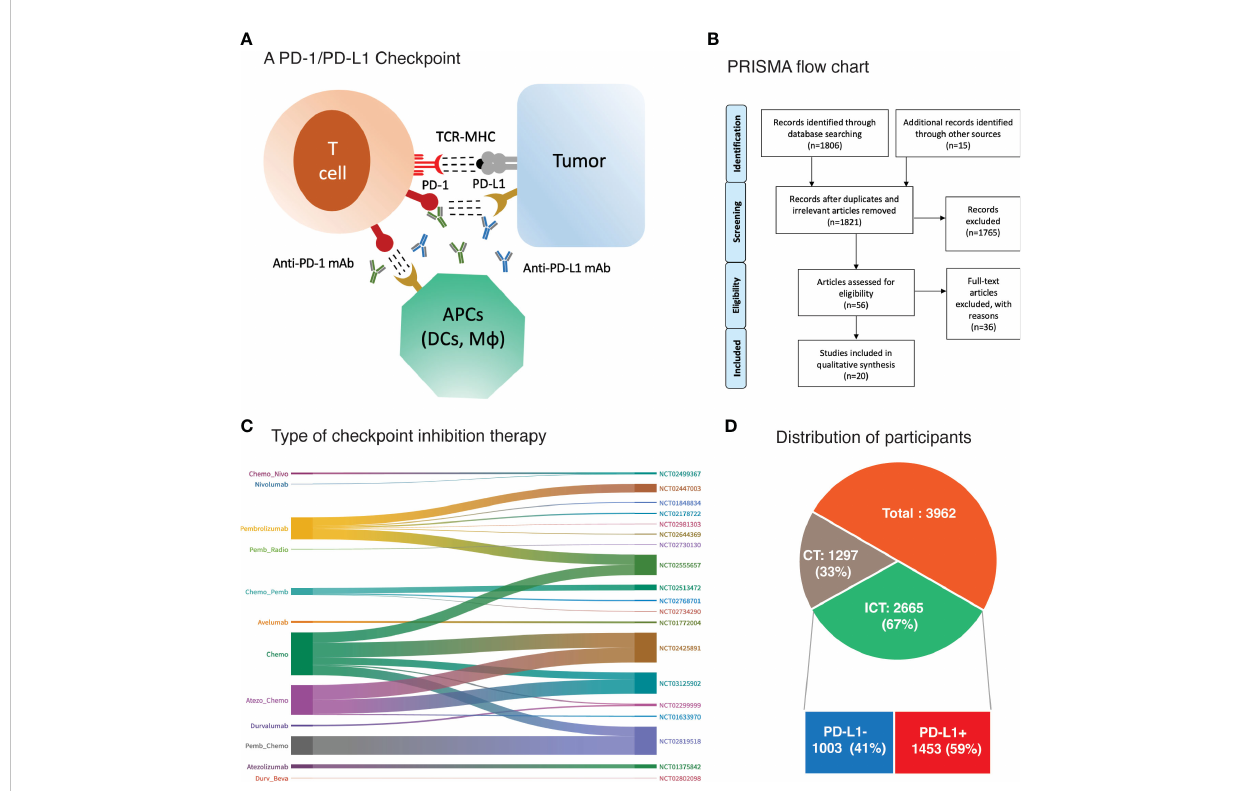
FIGURE 1 (A) Binding of checkpoint proteins, such as PD-1 on T cells and PD-L1 on tumor cells and antigen presenting cells (APCs), keeps T cells from killing tumor cells in the body. Blocking this interaction of PD-1 and PD-L1 with an immune checkpoint inhibitor (anti-PD-L1 or anti-PD-1) allows the T cells to kill tumor cells. DCs, dendritic cells; M f , macrophages (B) PRISMA fl ow diagram of research strategy and study selection. (C) Sankey diagram depicting treatment regimen and corresponding trial registration number. (D) Main cohorts and number of